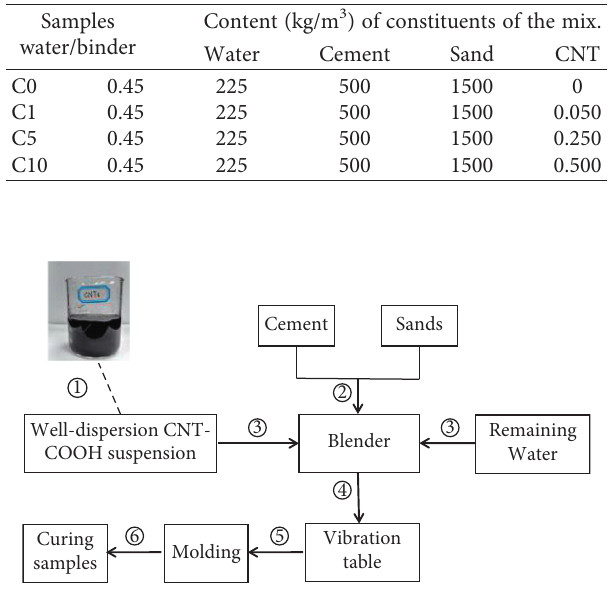
Figure 3: The procedure of casting CNT-COOH-modified cement